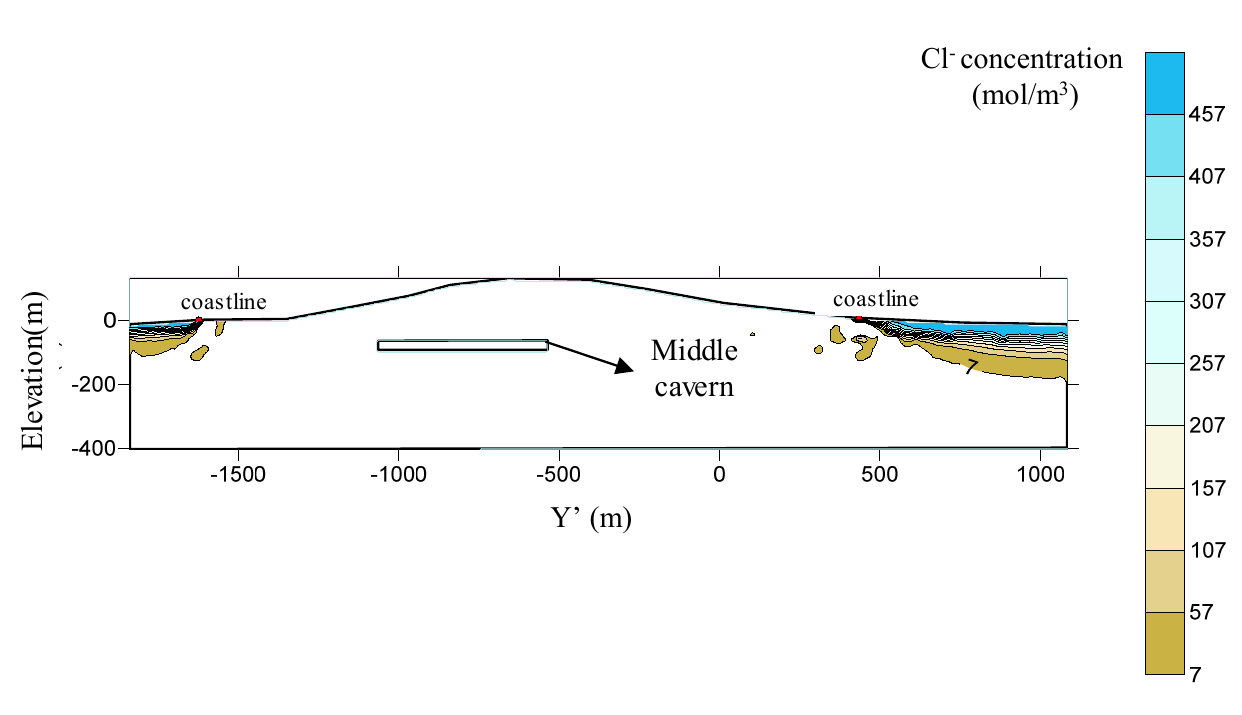
Figure 9. A sectional view of Cl − concentration contour crossing the middle cavern.